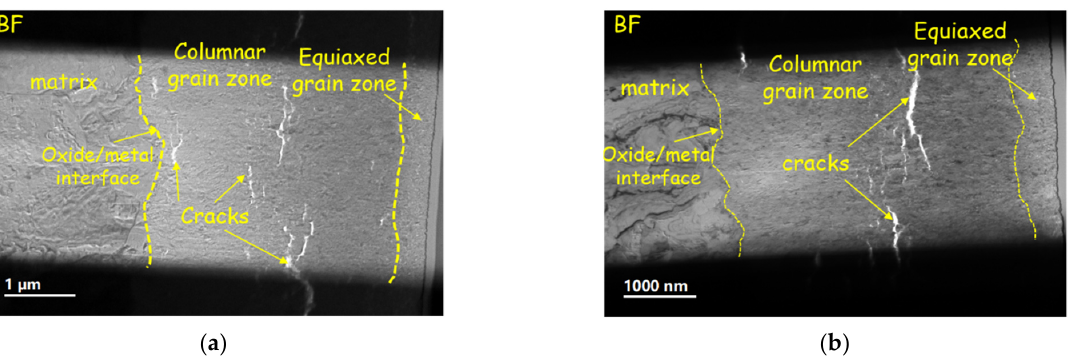
Figure 10. Oxide morphology of ( a ) original plates and ( b ) reprocessed plates corroded for 300 days. Some studies indicate that the undulation of the O/M interface affects the corrosion resistance [38]. The formation of lateral cracks on the convex position results from the increasing undulated roughness [39], which may cause oxide films to lose their protection and accelerate corrosion. After corroding for 100 days, the O/M interface of the original plates is straight, while of the reprocessed plates is more wavy and presents “hills” and “ridges”, which indicates that an O/M interface has larger roughness. Higher O/M- interface roughness is usually associated with the rapid growth of oxide films, which may be the reason for the faster corrosion rate of reprocessed plates.